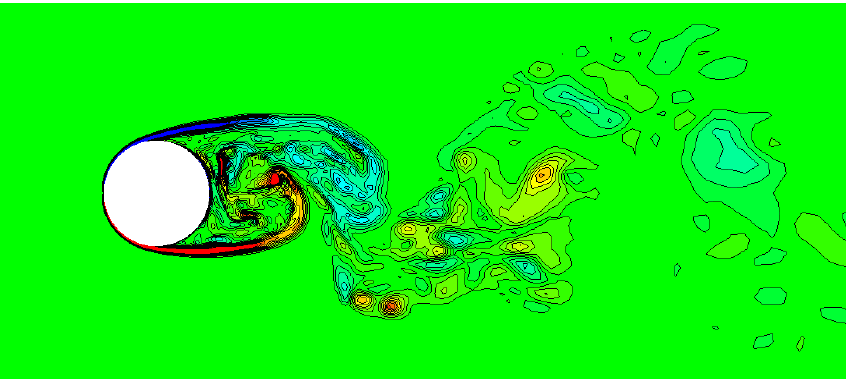
Figure 8. Contour of instantaneous spanwise vorticity ω z D / c ∞ in the near wake of flow over a circular cylinder; 20 contour levels from − 6 to 6 are shown.